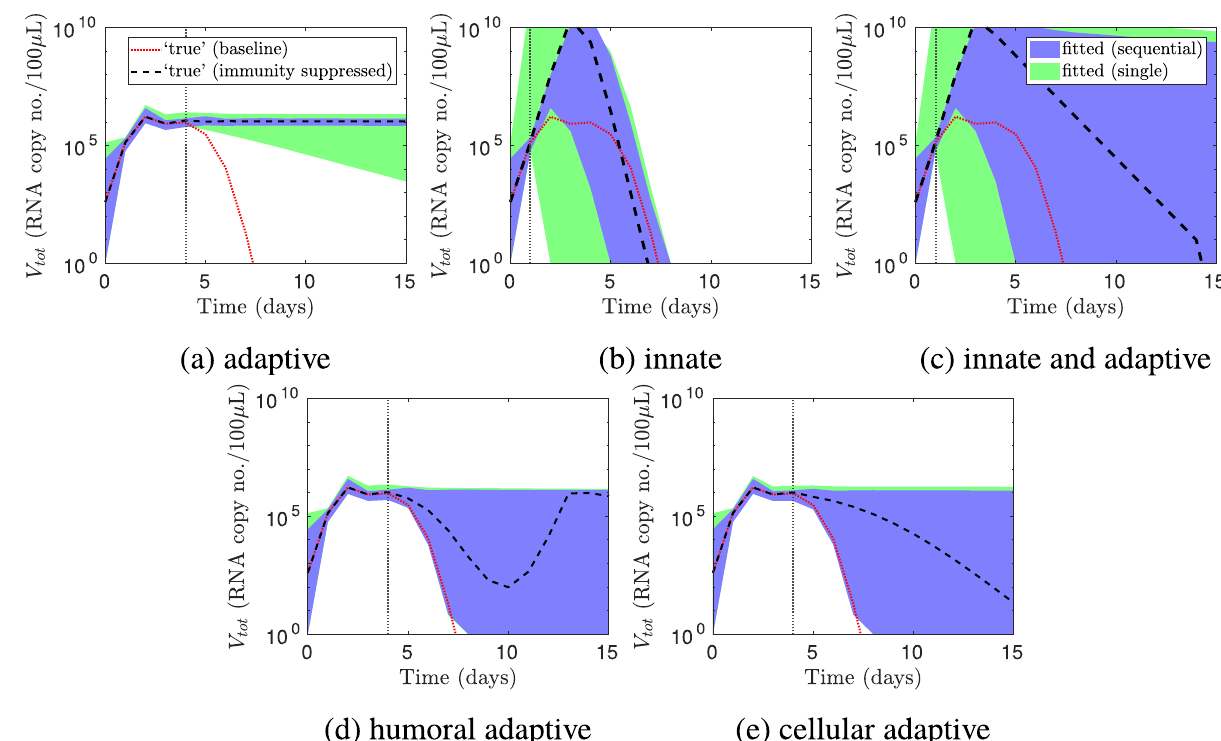
Fig 3. Predicting the viral load for a single infection when various immune components were absent. The vertical lines indicate, for the ‘true’ parameter values, the times at which the immune components labelled under each panel took effect. These times were determined by when the viral load for the baseline model (red dotted line) deviated from the viral load when the immune components were absent (black dashed line). These times were recovered using sequential infection data in all of the panels (95% prediction intervals for the viral load in blue), while the timing of adaptive immunity in (a) was recovered using single infection data (intervals in green). In addition, the viral load when adaptive immunity was suppressed was accurately predicted using sequential infection data (a). However, the viral load was not accurately predicted using either dataset in the remaining scenarios (b—e). Prediction intervals were constructed without measurement